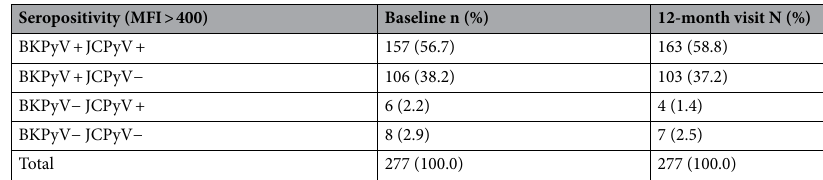
Table 2. The effect of pregnancy on BK (BKPyV) and/or JC (JCPyV) polyomavirus seropositivity assessed by comparing the seropositivity of 277 women at their 3rd trimester pregnancy (baseline) with their seropositivity one year later (12- month